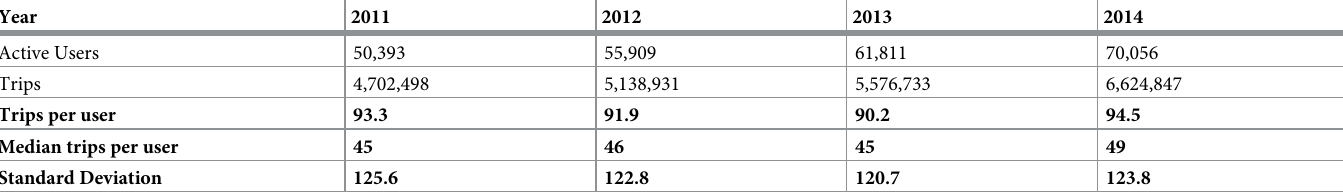
Table 1. Number of trips per active